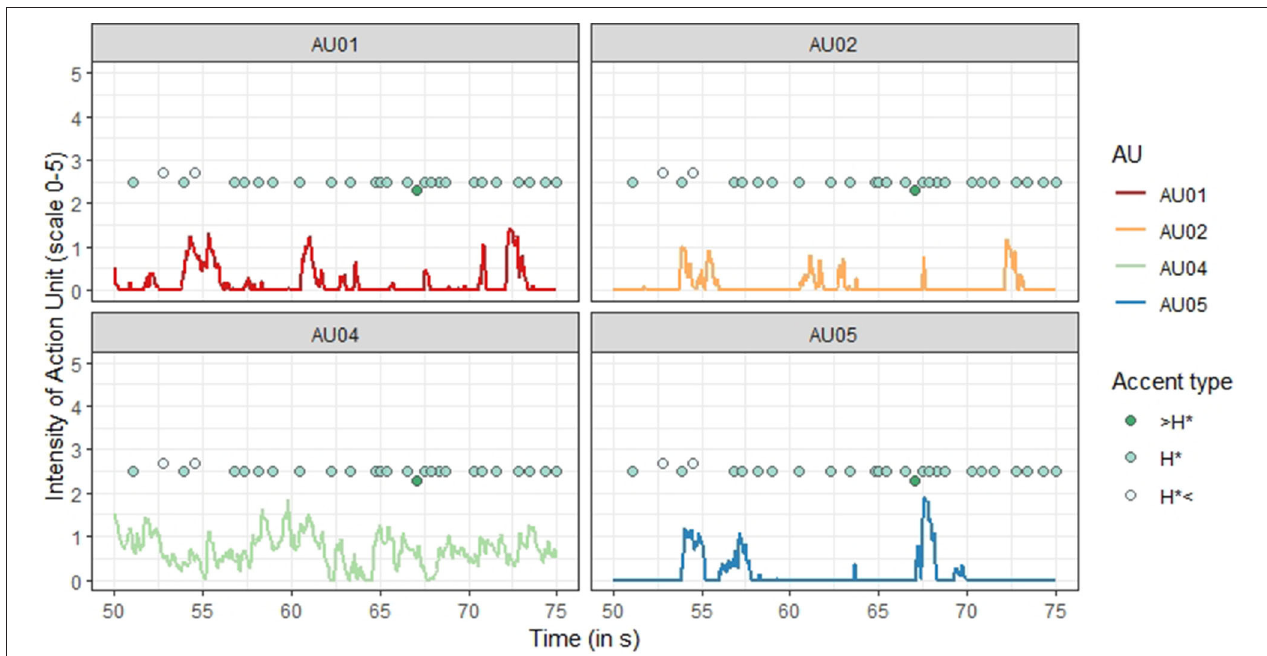
FIGURE 7 | Example of the occurrence of Action Units and pitch accents with their position relative to the prominent syllable. The intensity of each of the four Action Units (scale of 0–5) is shown for the first seconds 50 to 75 of the speech material of speaker LP. The pitch accents and their type are super-imposed, the y-axis does not refer to the accent type directly, but late peaks in the syllable after the prominent syllable (H* < ) are placed higher than pitch peaks within the prominent syllable (H*), which in turn are placed higher than early peaks in the syllable before ( > H*).